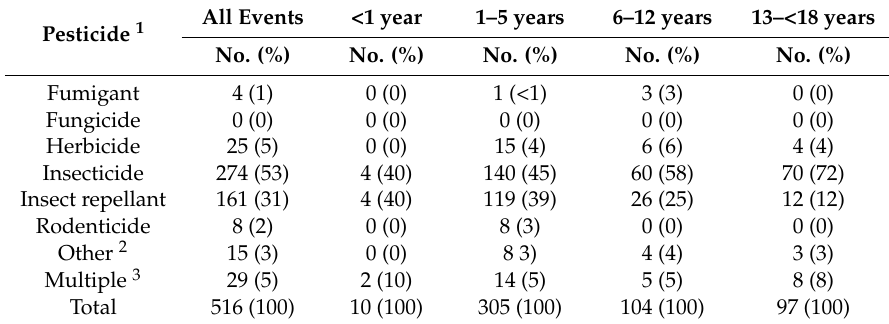
Table 8. Distribution of events in childhood reported by pesticide functional class and age